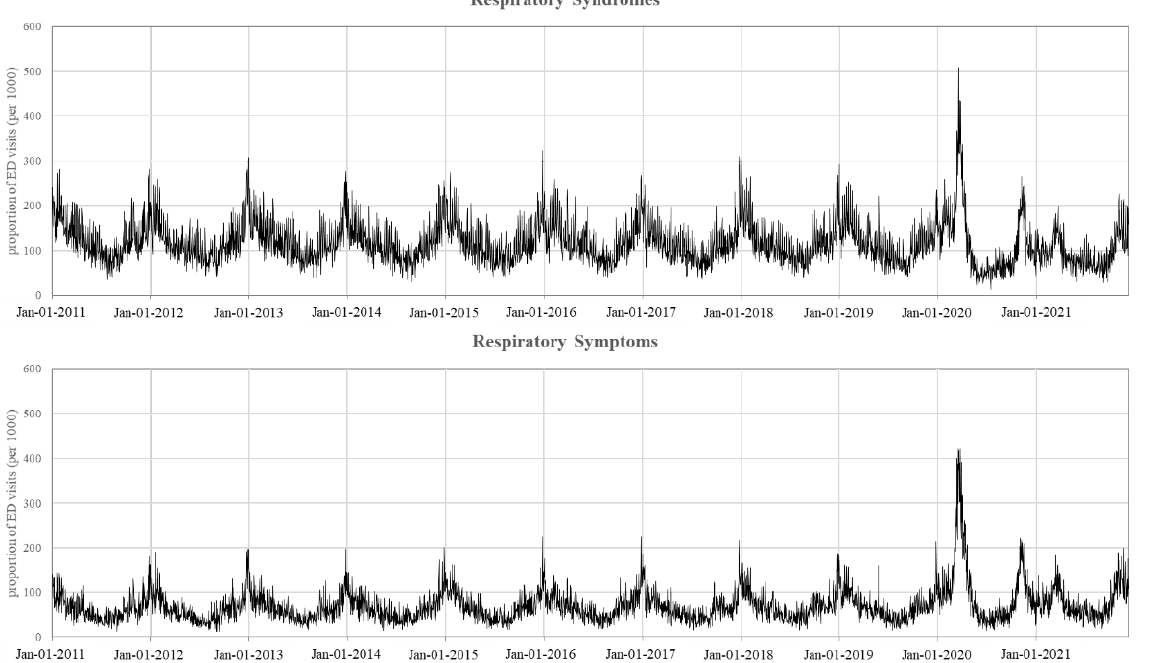
Figure 1. The observed daily number of ED visits associated with either respiratory syndrome read codes or recognized through respiratory symptoms extracted from the free text of medical records, between 1 January 2011 and 9 December 2021. As expected, the peak period for the respiratory syndromes and symptoms occurred between December and January of each year, and during the holidays and adjacent week- days. A decreasing yearly trend for both the considered outcomes was also observed. Figure 2 shows the model-based residual of the daily trends in the proportion of ED visits recognized as being associated with respiratory syndromes and symptoms, displayed as EWMA charts. Few and modest signals appeared in the period between 2011 and 2019, while four very intensive outliers of respiratory syndromes and symptoms occurred in March and November 2020 and 2021. A further peak of respiratory symptoms was observed in July 2021. It should be noted that the peaks were systematically more intense for symptoms than for